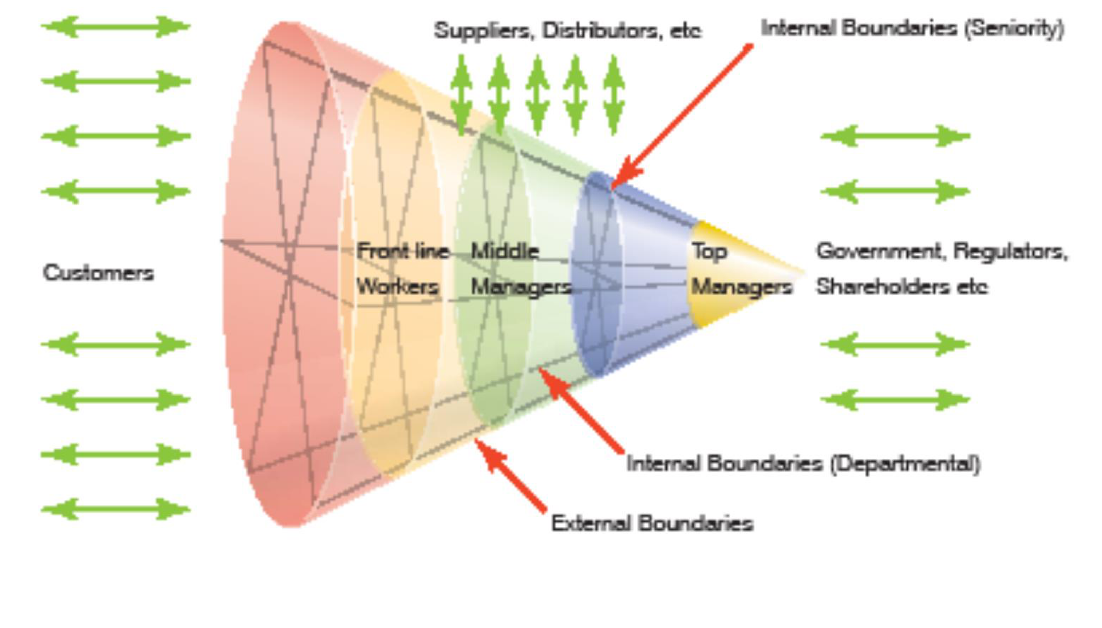
Figure 19: Hay’s Organisational Cone (Hay, 2016,